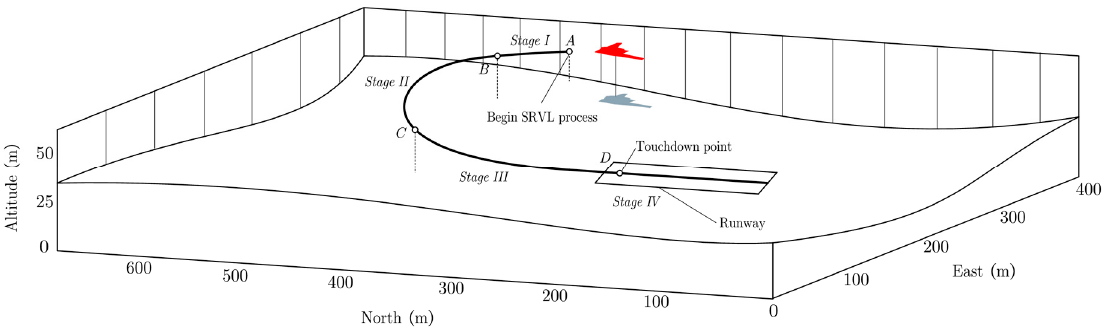
Figure 19. Short-landing process.